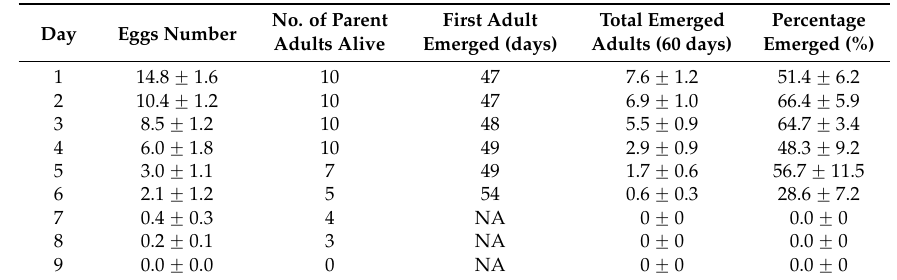
Table 1. Results of daily monitoring of egg laying by female C. maculatus under normoxic conditions. Female bruchid survival and the daily average number of eggs produced by surviving females were recorded *.